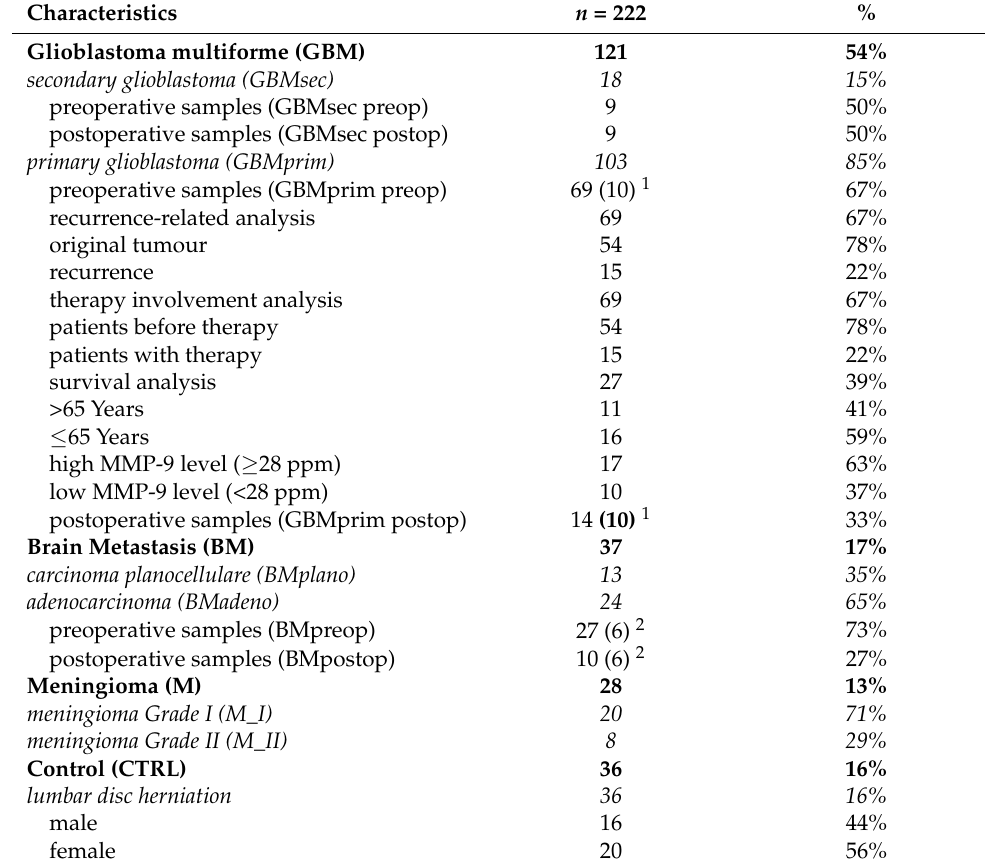
Table 1. Patient cohort and participation in the statistical